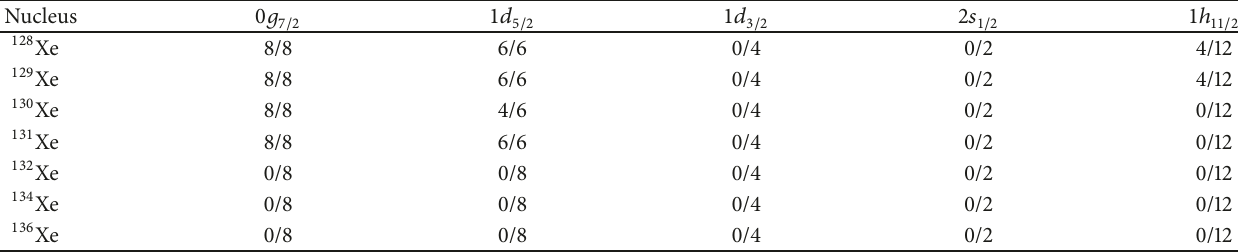
Table2:Thevalence-spacetruncationsmadeintheshell-modelcalculations.ThefirstcolumnlabelstheXeisotope;thefollowingfivecolumns give the minimum/maximum number of neutrons on the single-particle orbitals 0𝑔 7/2 , 1𝑑 5/2 , 1𝑑 3/2 , 2𝑠 1/2 , and 1ℎ 11/2 , respectively.